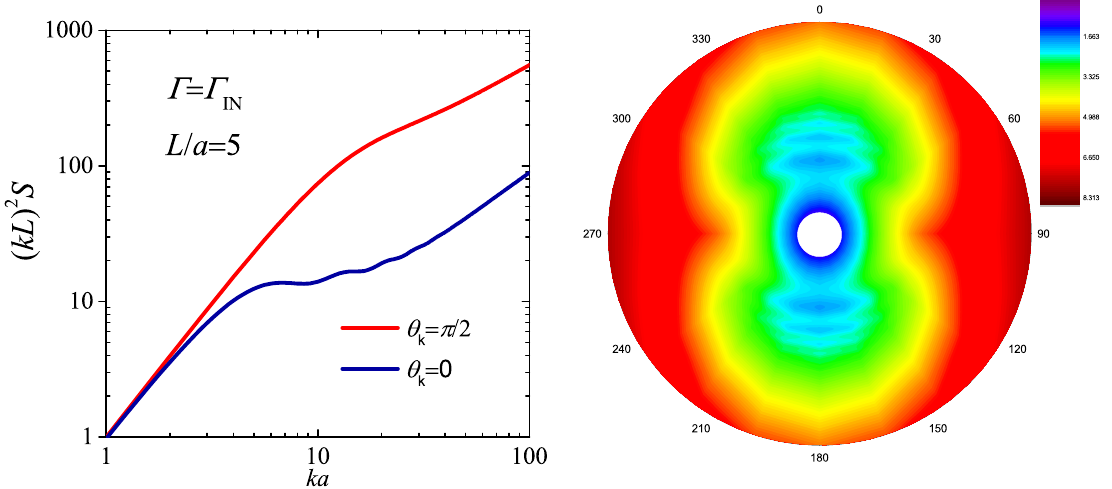
Figure 2. Structure factor, S ( θ t , k ) , of the WLC for L / a = 5 in a the nematic phase. The left panel shows the component of θ t = 0 and π /2 in double-logarithmic Kratky plot. The right panel demonstrates the anisotropic properties of S ( θ t , k ) in a polar